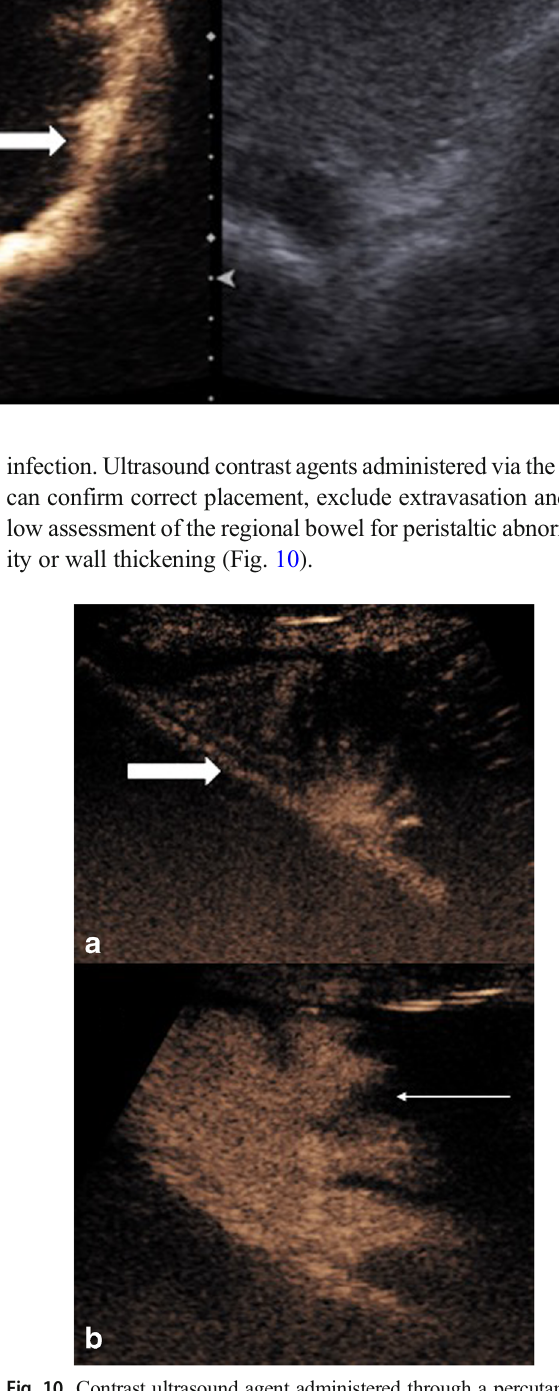
Fig. 10 Contrast ultrasound agent administered through a percutaneous jejunostomy (PEJ). (A) Ultrasound contrast instilled via the PEJ tube (thick arrow) confirms correct placement and no evidence of extravasation. (B) A magnified view shows thickening of the small bowel folds (thin